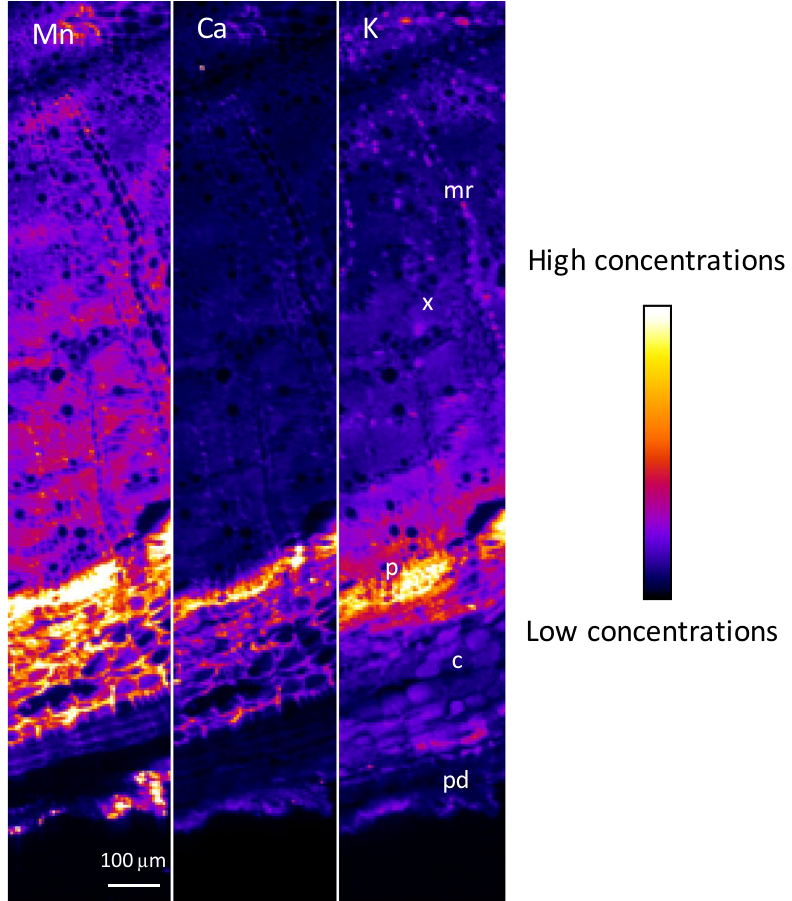
Figure 5. μXRF maps of Mn, Ca and K for a cross-section of a frozen hydrated primary root of transplanted Grevillea meisneri . The pixel size is 3 μm. The intensity scales are different between elements. c cortex, mr medullary ray, p phloem, pd periderm, x xylem.